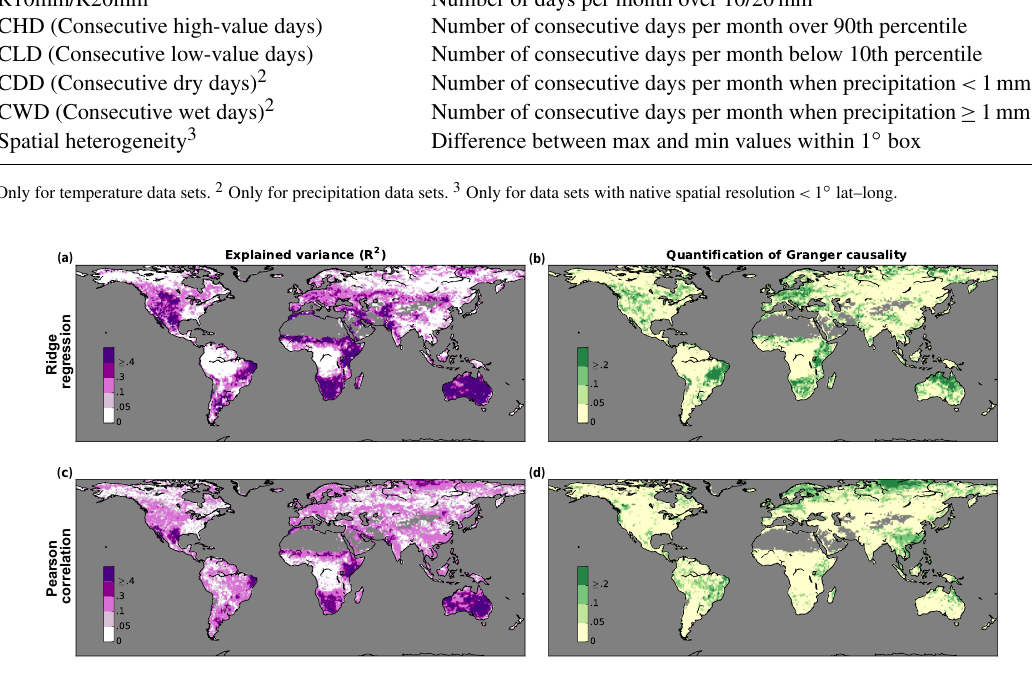
Figure 4. Linear Granger causality of climate on vegetation. (a) Explained variance ( R 2 ) of NDVI anomalies based on a full ridge regression model in which all climatic variables are included as predictors. (b) Improvement in terms of R 2 by the full ridge regression model with respect to the baseline ridge regression model that uses only past values of NDVI anomalies as predictors; positive values indicate (linear) Granger causality. (c) A filter approach in which the variable with the highest squared Pearson correlation against the NDVI anomalies is selected. (d) Improvement in terms of R 2 by the filter approach with respect to the same baseline ridge regression model that uses only past values of NDVI